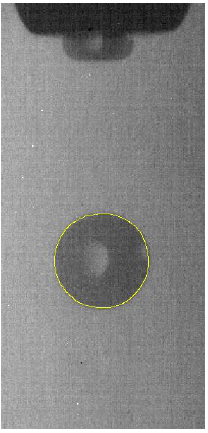
Figure 10. Droplet contour extraction (sub-pixel accuracy).